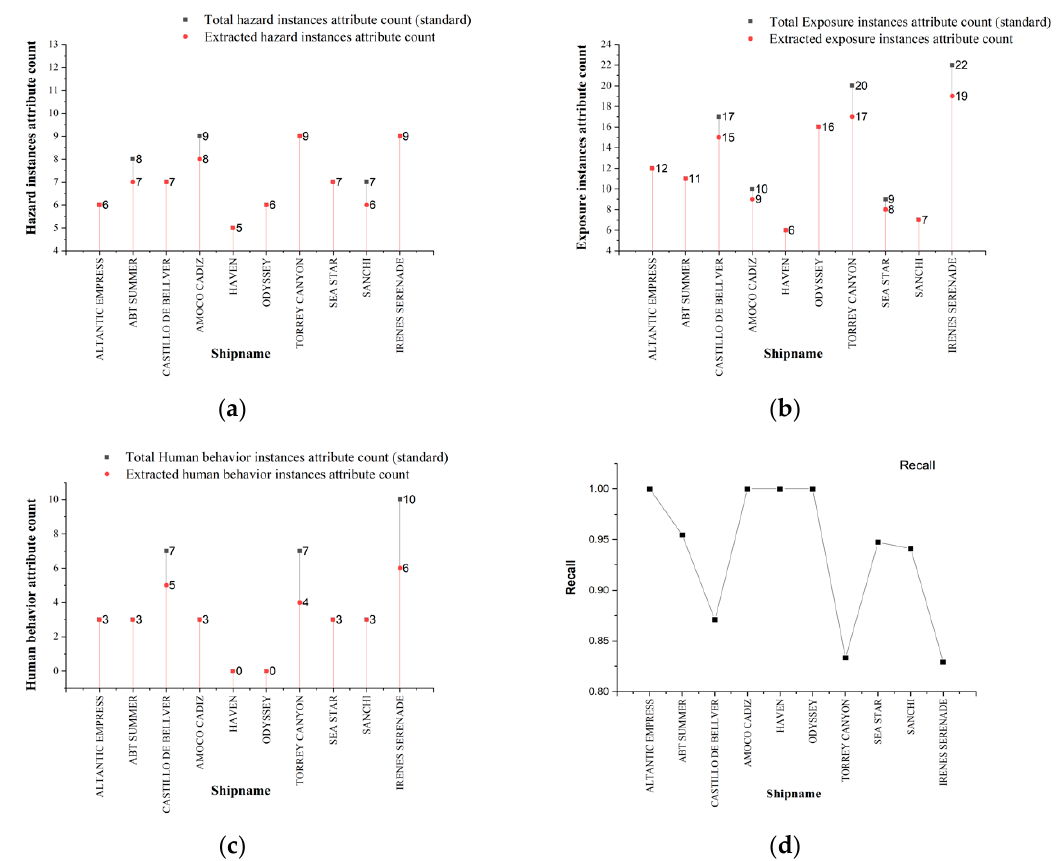
Figure 6. ( a – c ) show the statistical results for the attribute counts of the three components and ( d ) shows the recall of the proposed framework for each marine oil spill event.